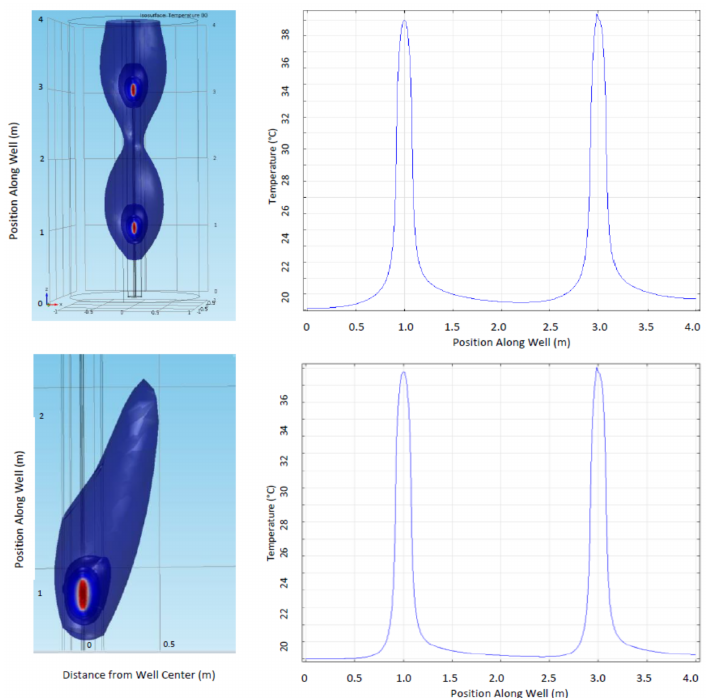
Figure 10. Isothermal surfaces ( left ) and temperature along the central axis of the well ( right ) for water movement (Darcy Flux) of 0.1 m/h in rock surrounding a well modeled using COMSOL 4.3b. Top figures are for vertical, upward flow, bottom is for upward flow at an angle of 15 degrees from vertical. The system is comprised of a heater and DTS sensor centered within 0.1 m of grout within a steel casing, with no water movement within the casing. Temperature along central axis is presented, as would be recorded by DTS, shows asymmetry in peak shoulder shape and cumulative warming as water rises (toward right). Material parameters similar to those expected in the field experiment were used in the modelling, but such a match is approximate since material testing was not conducted within or near the